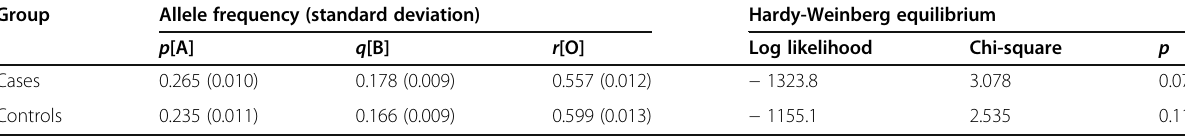
Table 2 Estimated frequencies of ABO blood group alleles in COVID-19 cases and controls Group Allele frequency (standard deviation)